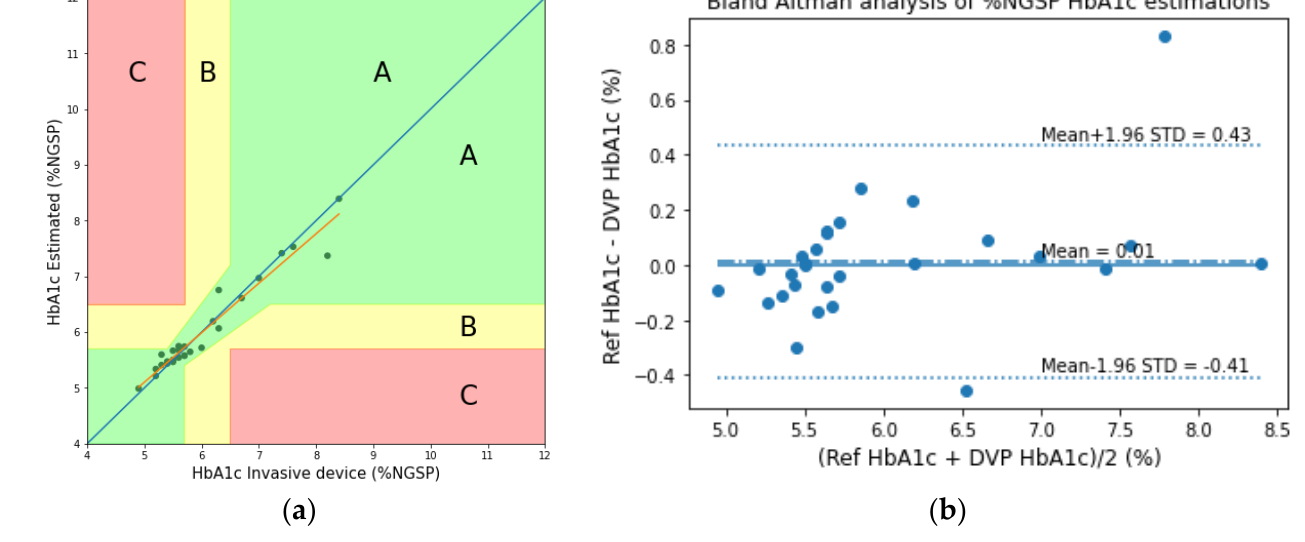
Figure 22. ( a ) EGA and ( b ) the Bland – Altman analysis plots of the experimentally acquired data for